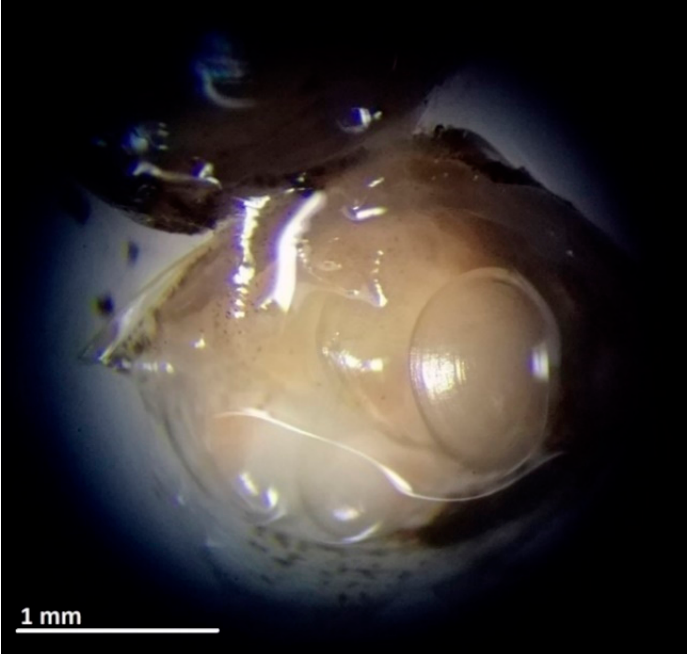
Figure 8. Mollusc HUB03-02: adult incubating 7 juveniles ready to be released (stereomicroscope 40× magnification).